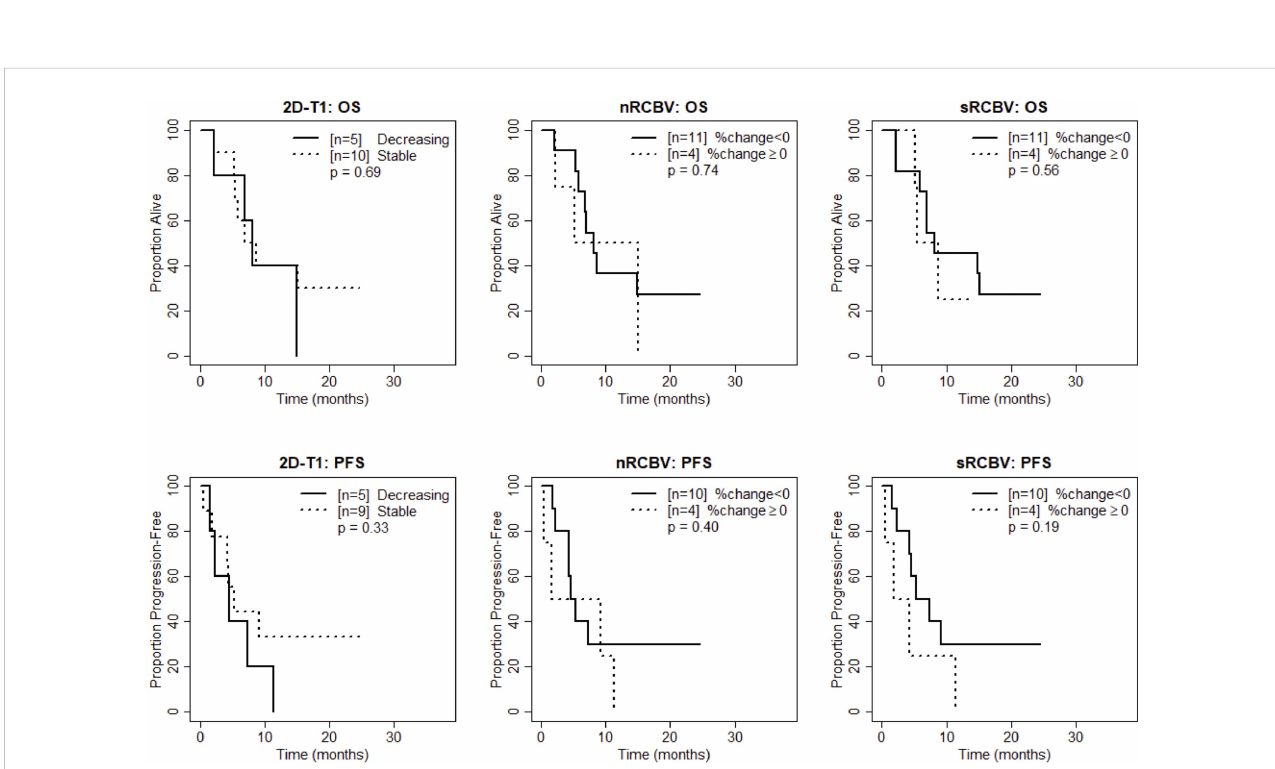
FIGURE 3 Kaplan-Meier curves using week 8 DSC-MRI for time to death (top row) and time to progression or death (bottom row) for T1 non-progressors with stable versus decreasing enhancement on 2D-T1 (left column), T1 non-progressors with decreasing versus increasing normalized rCBV (nRCBV) (middle column), and T1 non-progressors with decreasing versus increasing standardized rCBV (sRCBV) (right